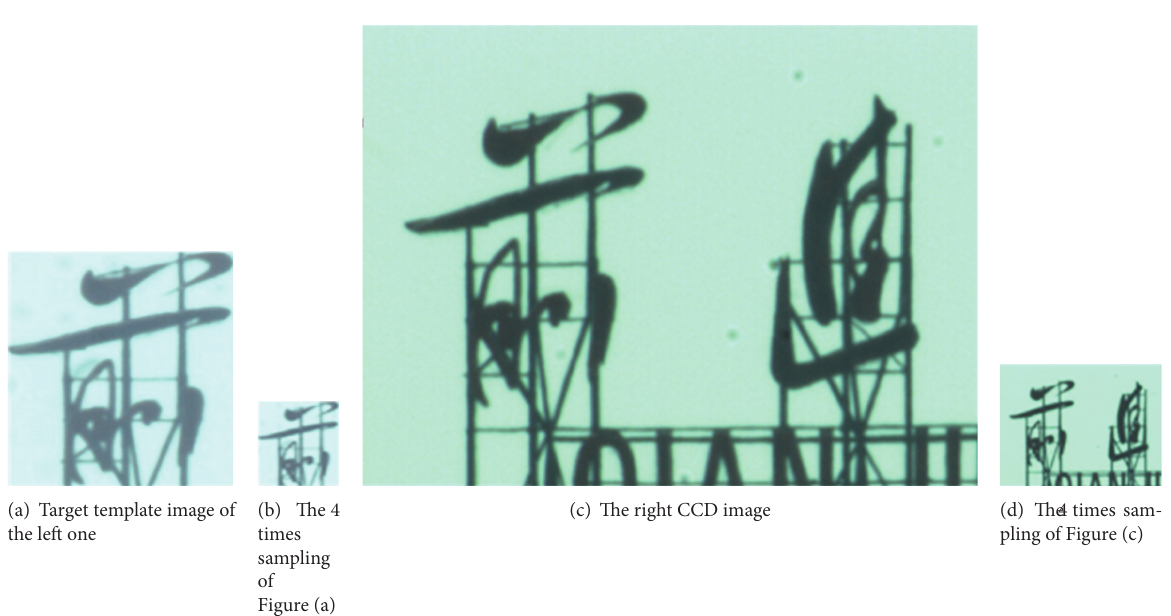
Figure 4: Downsampling of the target template image and the original left